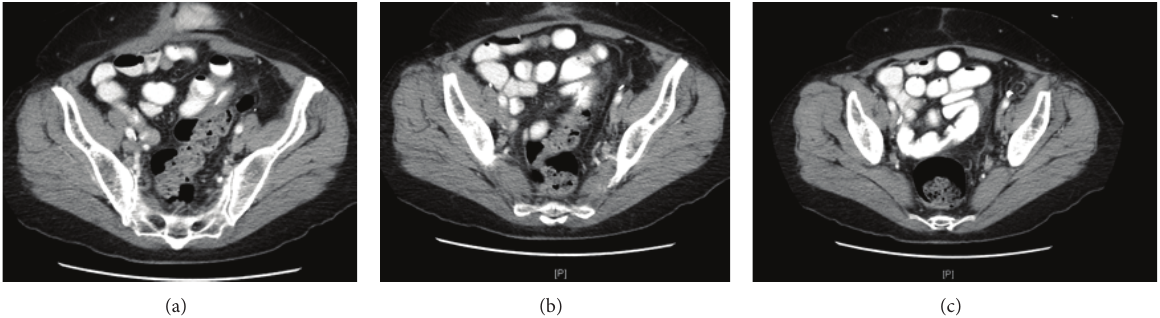
Figure 3: Serial images from a CT of the abdomen and pelvis with IV and oral contrast show the peritoneal catheter in the lower pelvis. The catheter approaches and then enters a loop of small bowel, confirming the position of the catheter as seen in the prior fluoroscopic